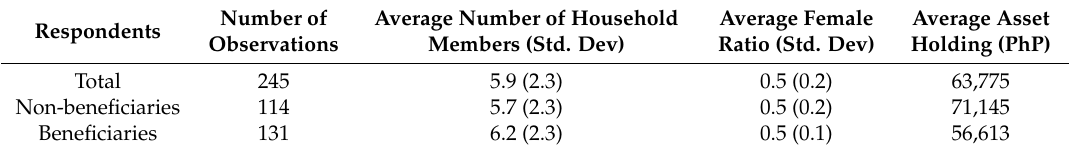
Table 2. Family composition and assets of the sampled households for non-beneficiaries and